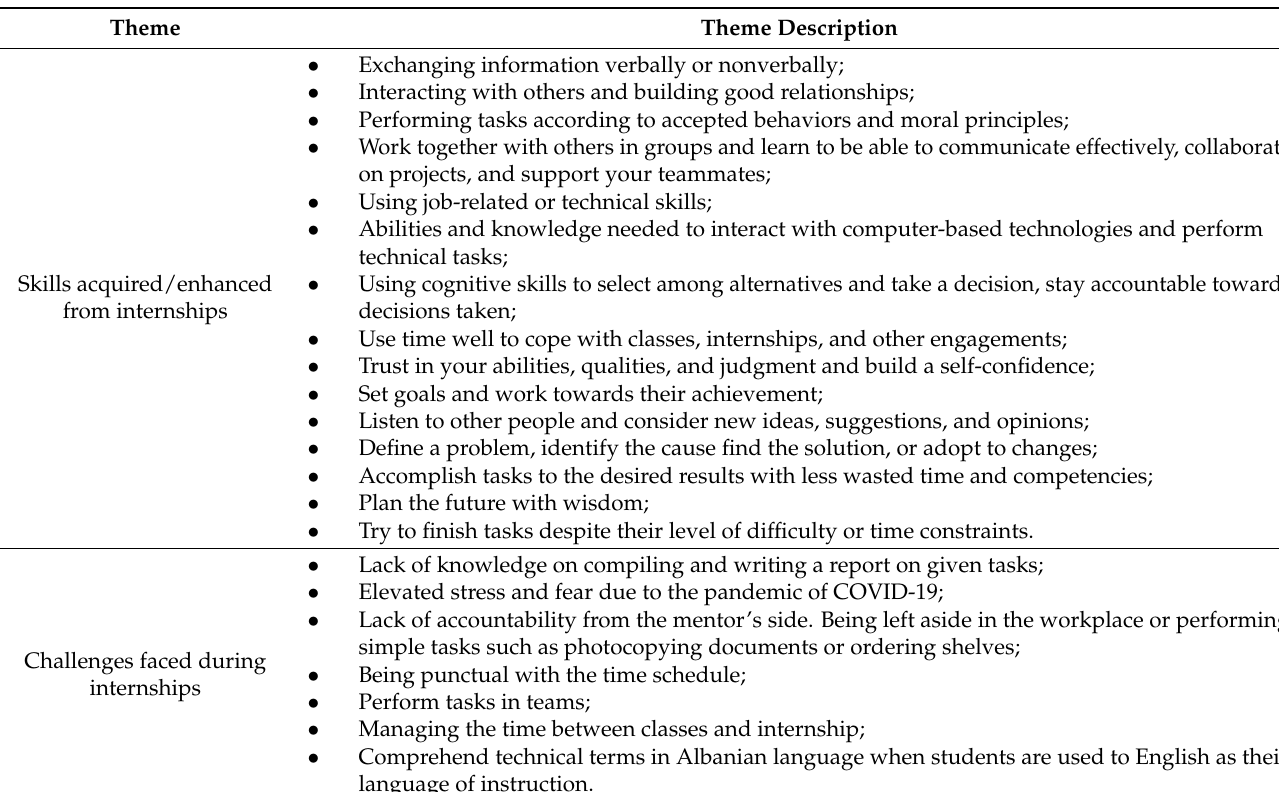
Table 7. Themes identified from internship